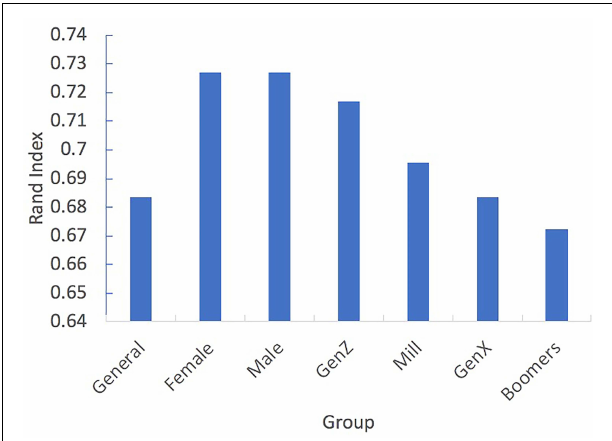
FIGURE 5 | Rand similarity index between corpus-based partition (cue word categories) and each of the seven data-driven consensus partitions for each of the networks.